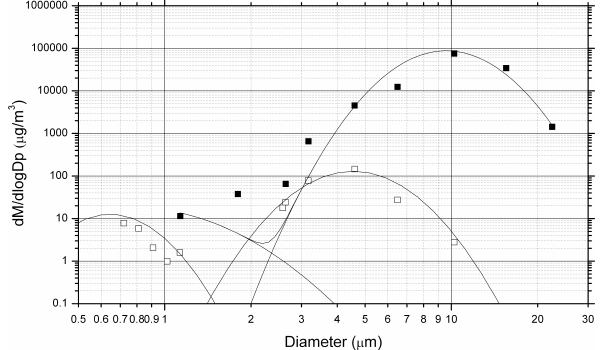
Fig. 15. Cloud generation experiments. Droplet size distribution at the maximum mass concentration during an expansion procedure (open squares) and during a saturation procedure (black